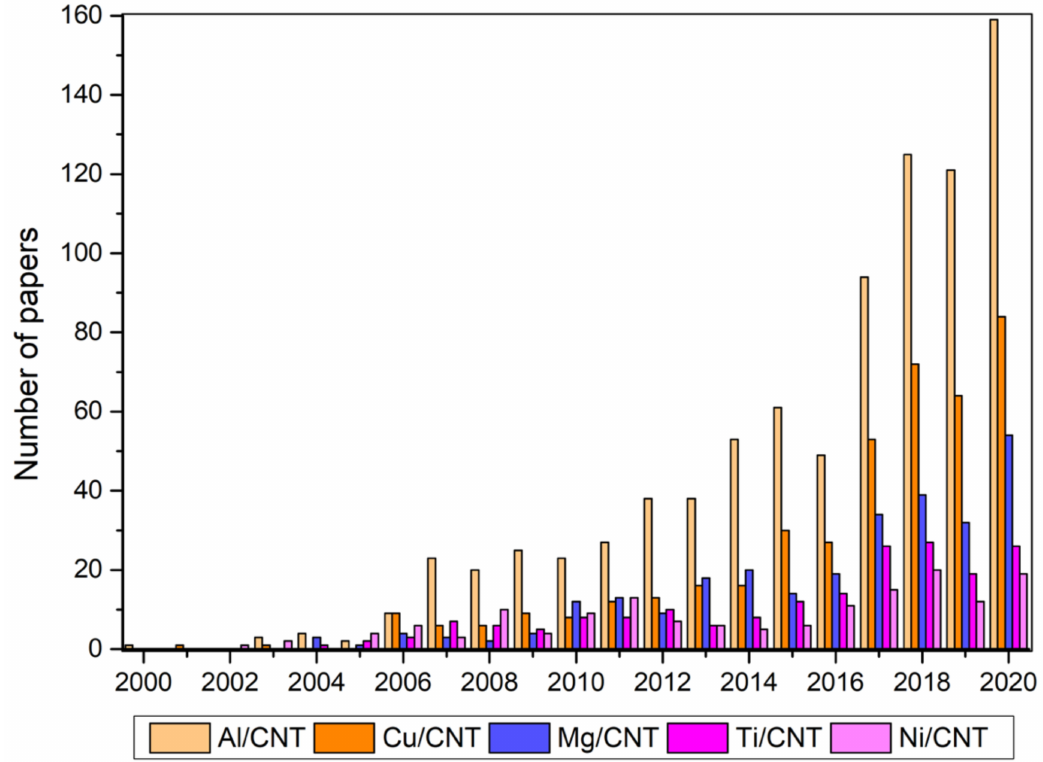
Figure 1. Evolution of the number of published papers, since 2000, on metal matrix composites reinforced by CNT.